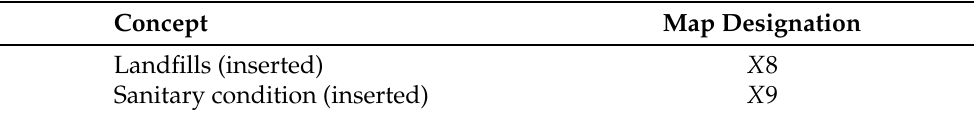
Table 4. Additional concepts injected to the fuzzy cognitive map determining the ecological state of the city.